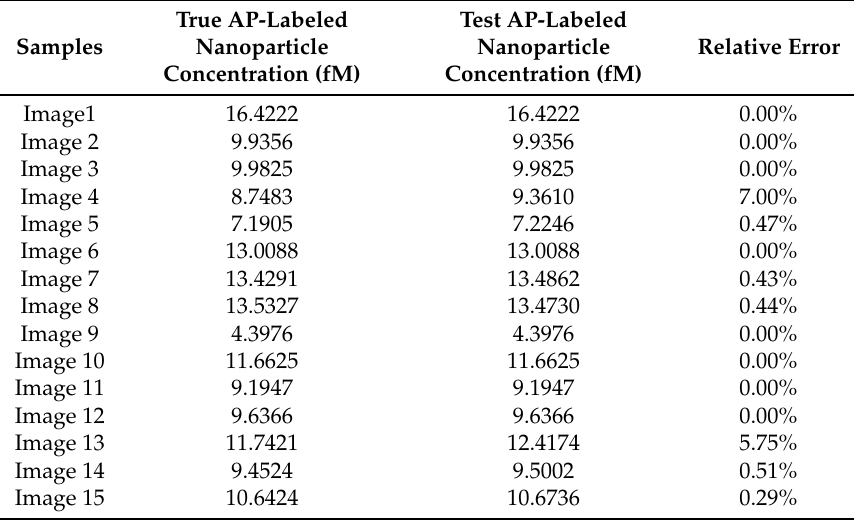
Table 4. Comparison evaluation of the alkaline phosphatase (AP)-labeled nanoparticle concentration